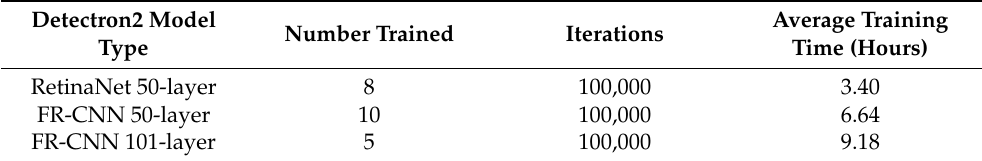
Table 2. Detectron2 API model training summary (HPC